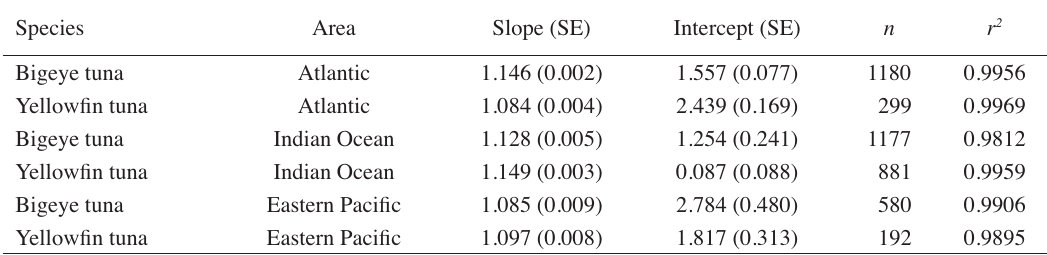
Descriptive statistics and the parameters in the relation between gilled-gutted weight and whole weight for bigeye- and yellowfin tunas from the Atlantic, Indian, and eastern Pacific oceans